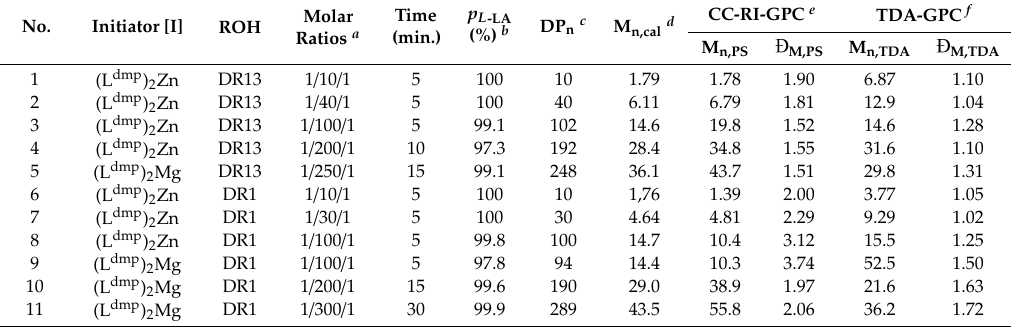
Table 1. Ring-opening polymerization (ROP) of L -LA initiated by zinc and magnesium complexes with Disperse Red 1 (DR1) and Disperse Red 13 (DR13) as